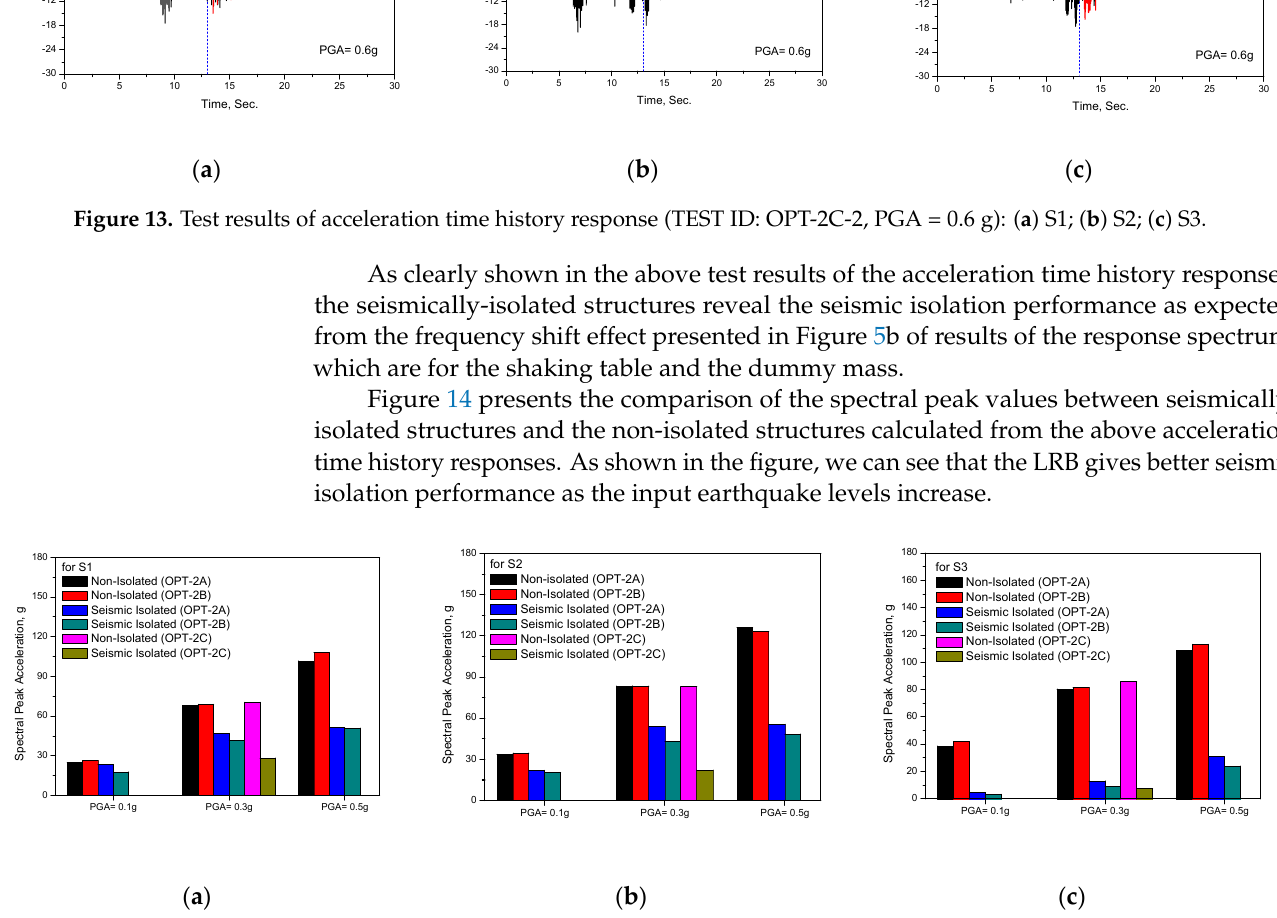
Figure 14. Comparison of spectral peak values calculated from the test results: ( a ) S1; ( b ) S2; ( c ) S3. From the above acceleration seismic responses, the results of the shaking table tests of the lead inserted small-sized LRB are summarized as